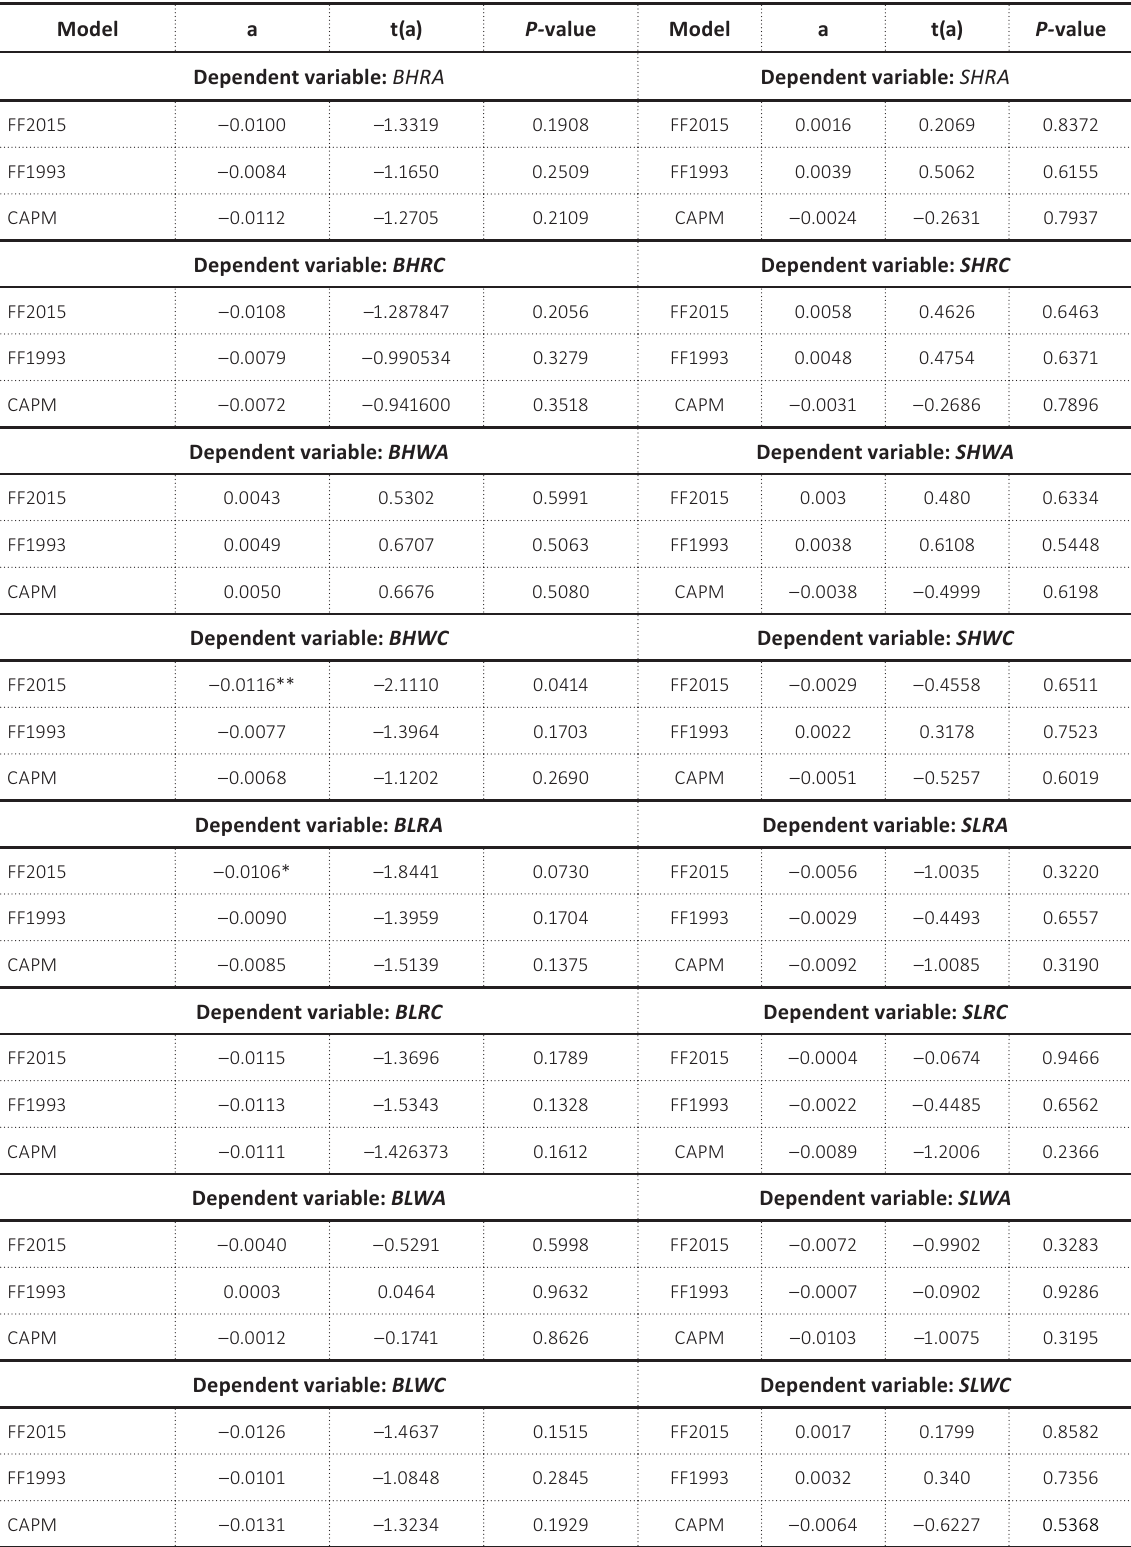
Table C1. Intercepts: 2x3 factors sort on Size and B/M, Size and OP, Size and